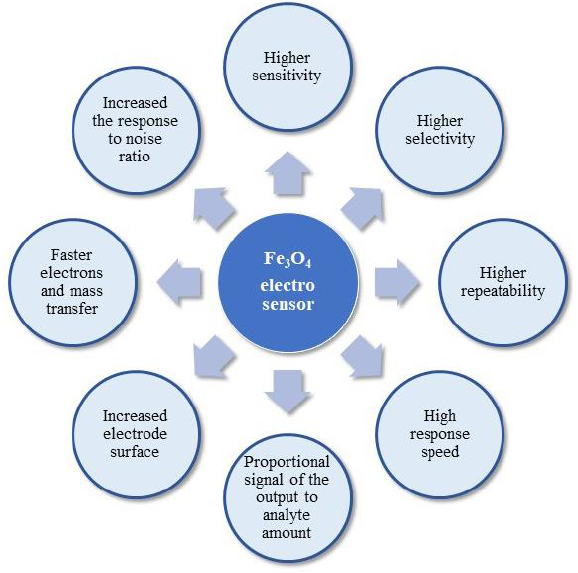
Figure 2. Scheme of the important electro-sensor features.